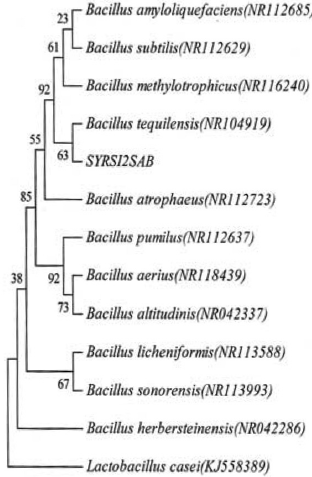
FIGURE 2 - Neighbor-joining tree based on 16S rRNA (1425) sequences showing the relationship between unknown isolate SYRSI1SAB and other closely related species of the genus Bacillus.